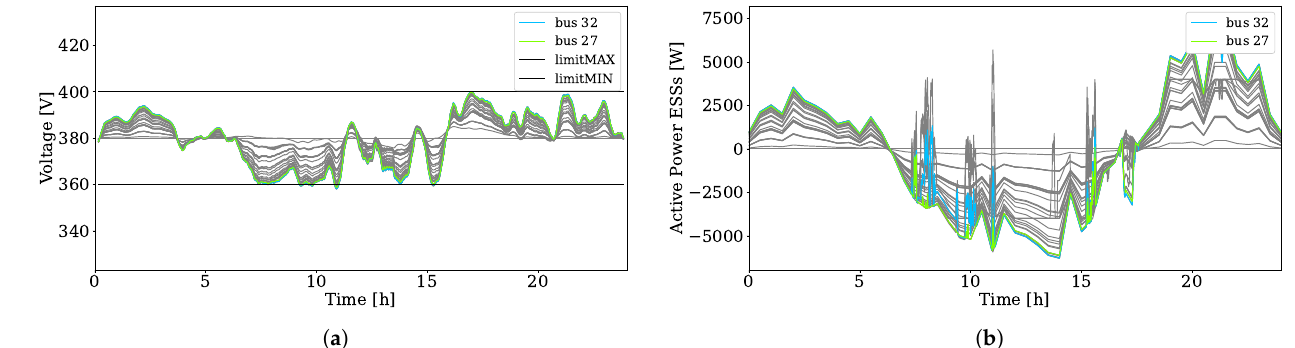
Figure 15. Results without the MPC. ( a ) Voltage with no MPC applied; ( b ) active power ESS set-points.